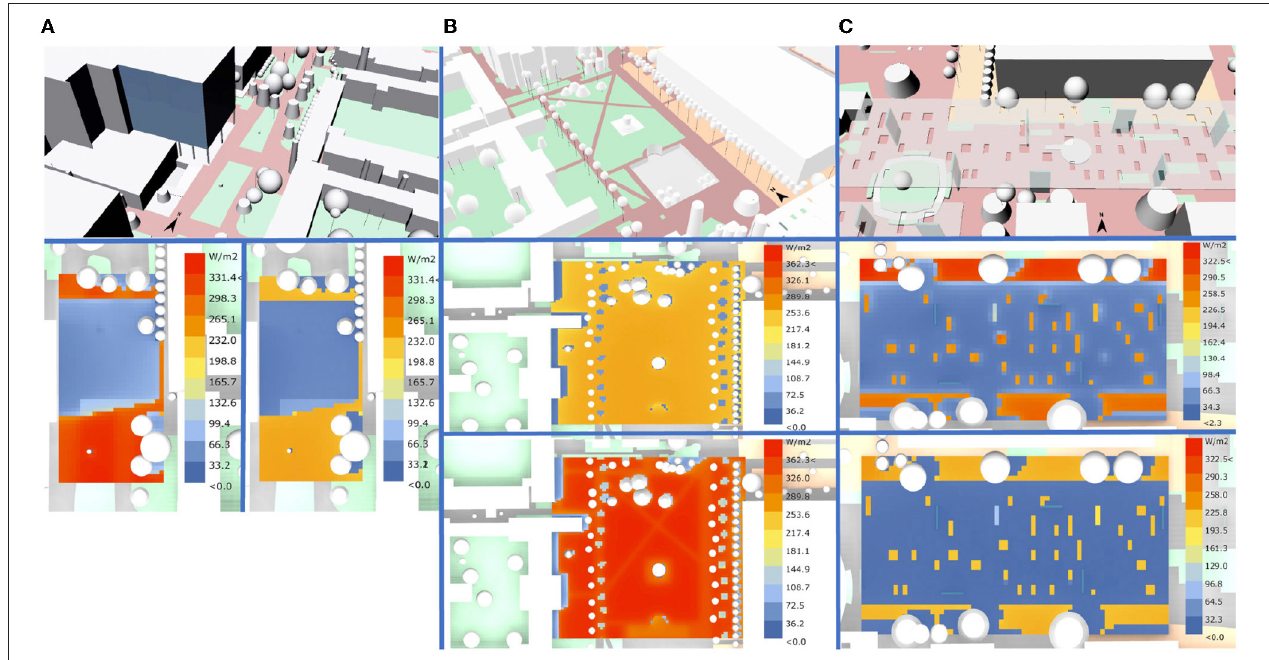
FIGURE 12 | [ (A) , left] Simulated mean spherical irradiance map of Forest Ave site using modeled site geometry (top) simulating with interreflections (left) or without (right) surrounding interreflections at 3 pm, May 18. [ (B) , middle] Simulated from local geometry (top) of mean spherical irradiance map for Hayden Lawn with (left) or without (right) surrounding interreflections at Hayden Lawn at 10 am on May 18. [ (C) , right] Simulation using geometry of MUPV site (top) showing mean spherical irradiance map with (left) or without (right) surrounding interreflections at 12 pm, May 18.